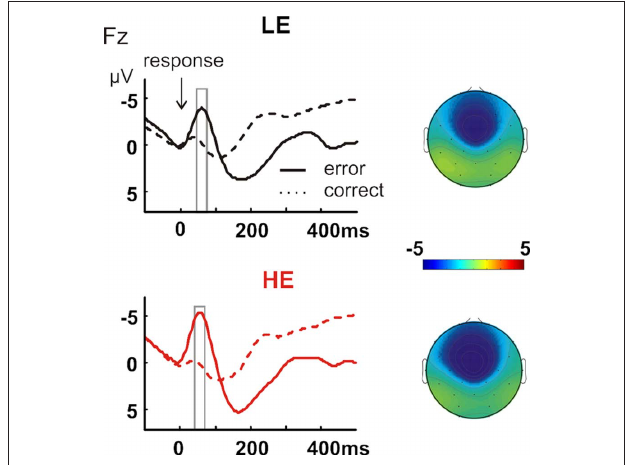
FiguRE 3 | Response-locked ERPs for error (solid line) and correct (dashed line) trials, separately for the LE (upper row, black lines) and HE group (lower row, red lines). The time-window of interest for the error- related negativity (30–80 ms) is indicated with a gray box and the respective topographical maps of the average amplitude in the time-window of interest is shown separately for the two groups (upper map: LE; lower